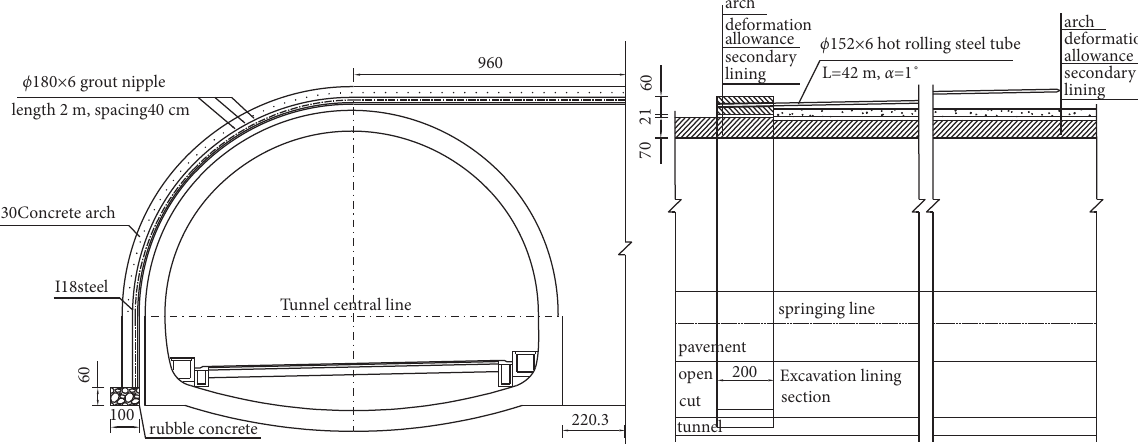
Figure 4: Pipe roof structure diagram (cm).